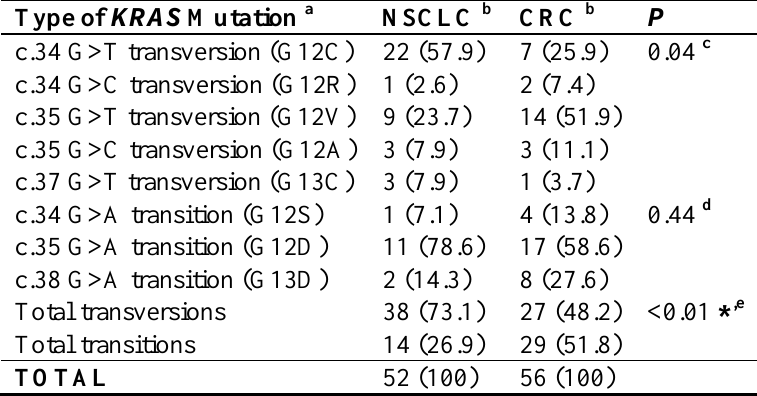
Table 5. Nucleotide and amino acid changes in KRAS in patients with non-small cell lung carcinoma (NSCLC) and colorectal cancer